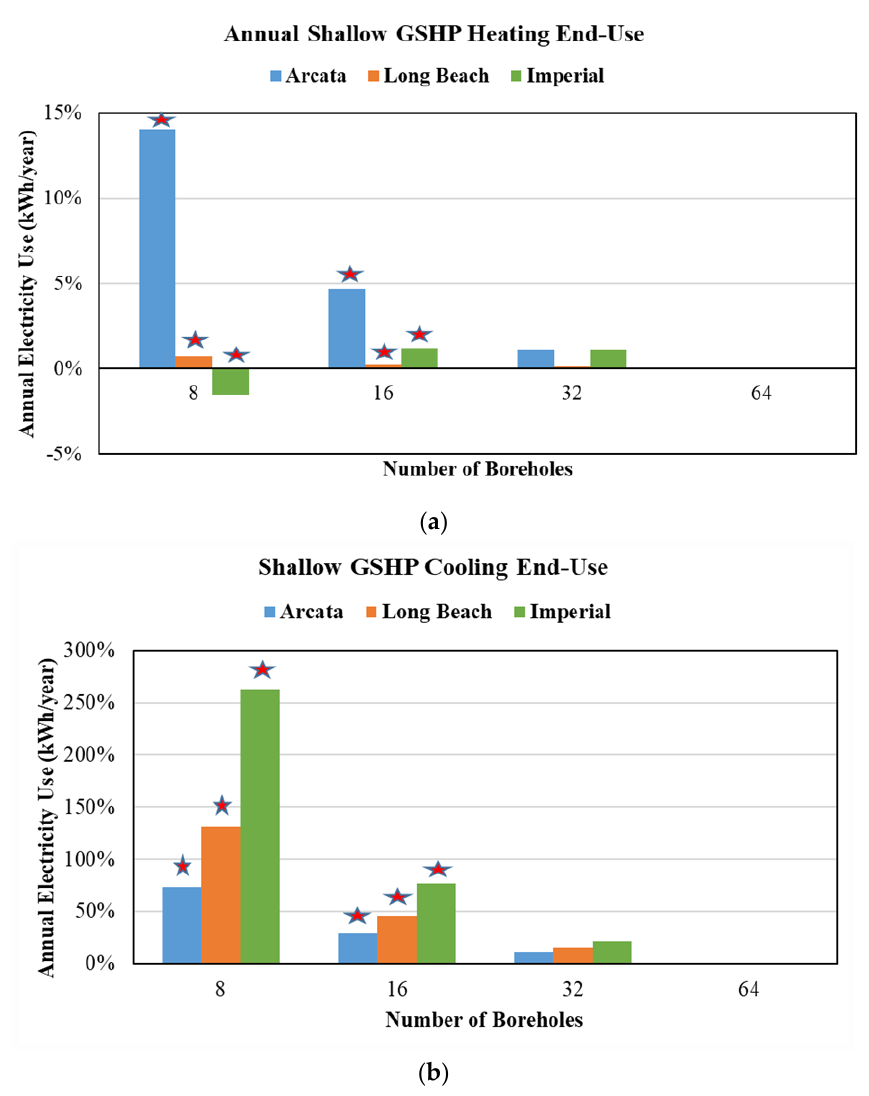
Figure 9. Percent increase relative to the case of 64 boreholes in annual ( a ) heating and ( b ) cooling electricity end uses for various numbers of 6.7 m (22 ft) boreholes when the prototypical house is located in three California locations.